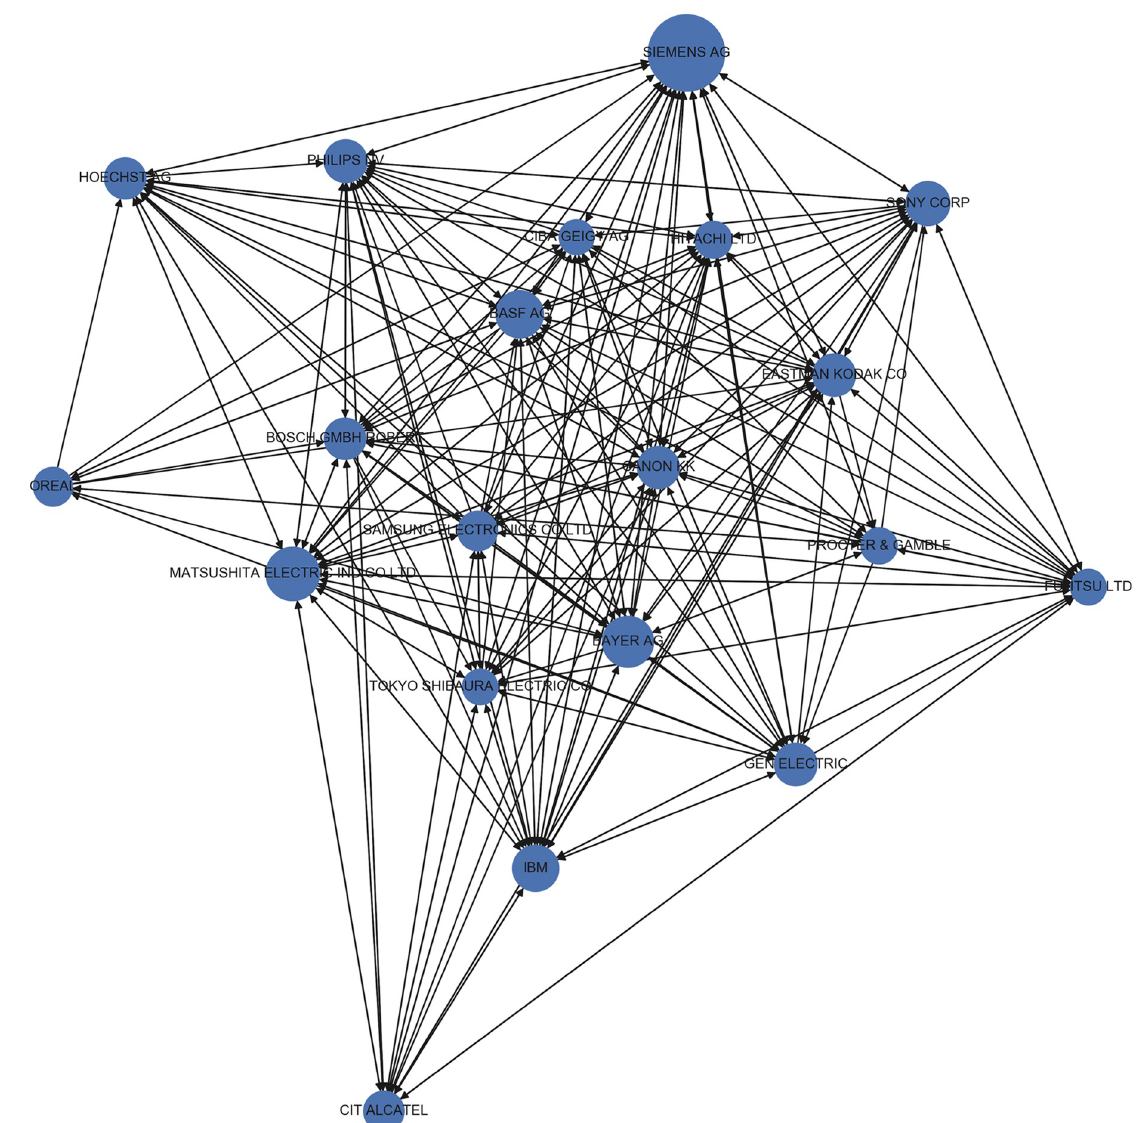
Fig 6. Citation network among top-20 prolific companies (best viewed in